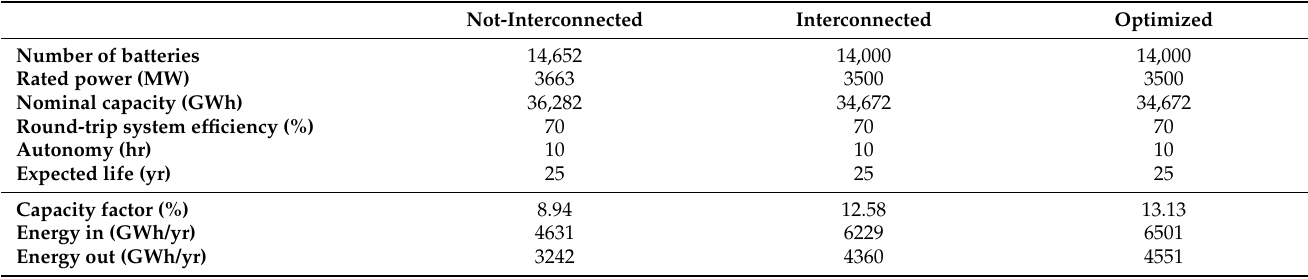
Table 14. Mega-batteries storage system